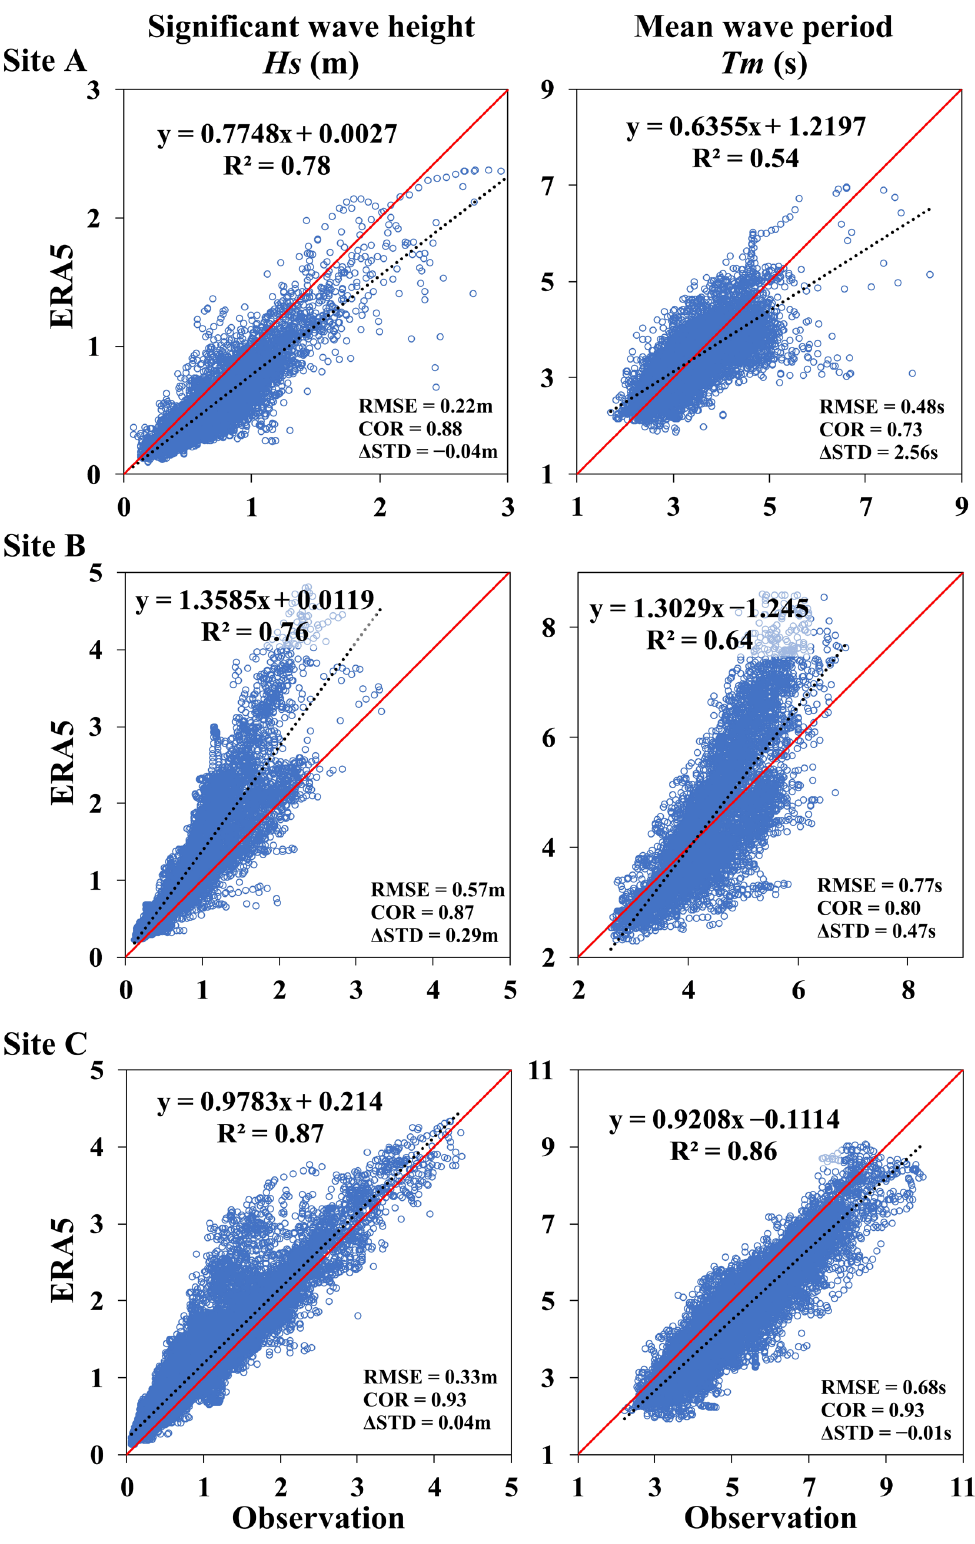
Figure 2. Comparison of significant wave height and mean wave period output by ERA5 model with measured data. The upper, middle, and lower panels display the results of Sites A, B, and C, respectively. The blue circles are scattered plots of observations compared with ERA5, and black dotted lines are corresponding fitting lines, whose formulas are shown in the upper left corner. The red lines are the 1:1 lines.